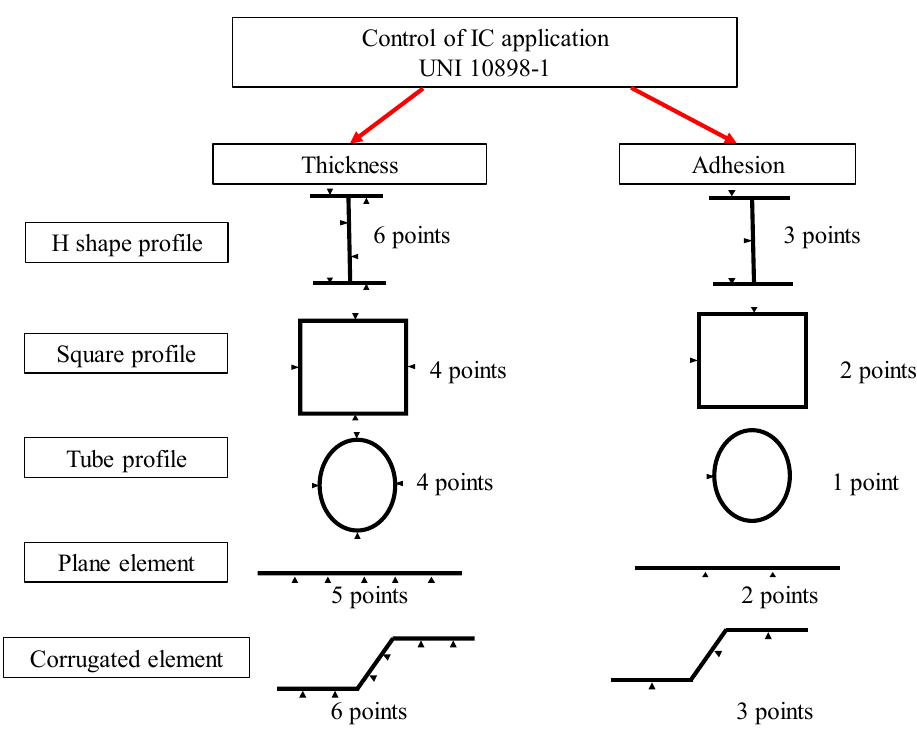
Figure 15. Measurement points for checking.